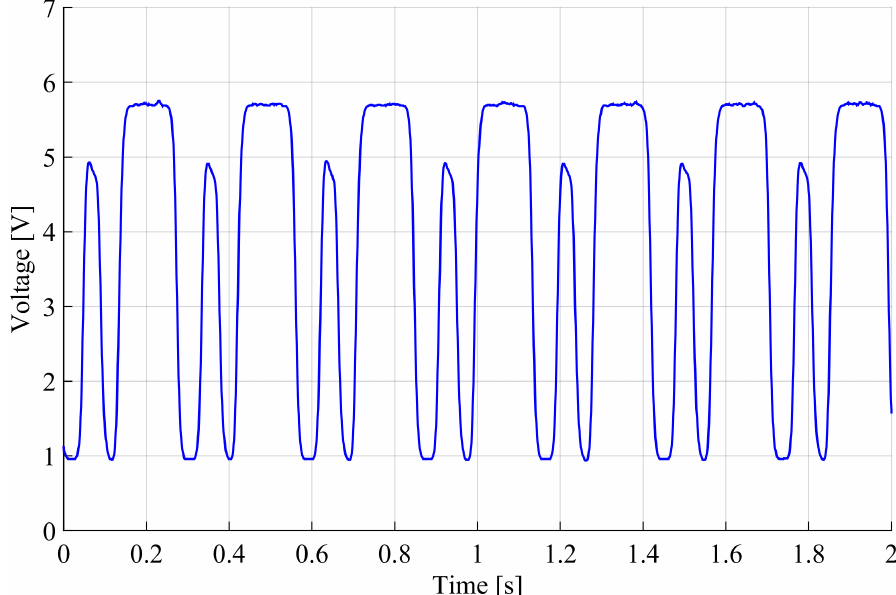
Figure 6. Calibration of the inductive sensor. The graph shows seven revolutions of the shaft of the motor.